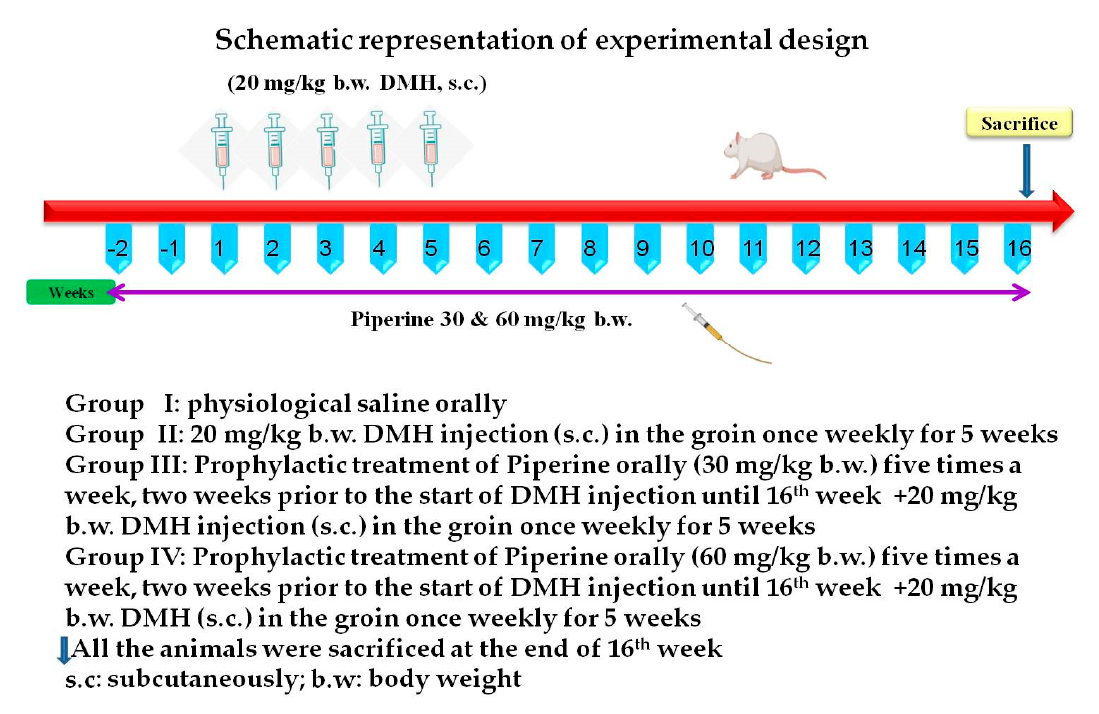
Figure 1. Represents treatment schedule of the study.